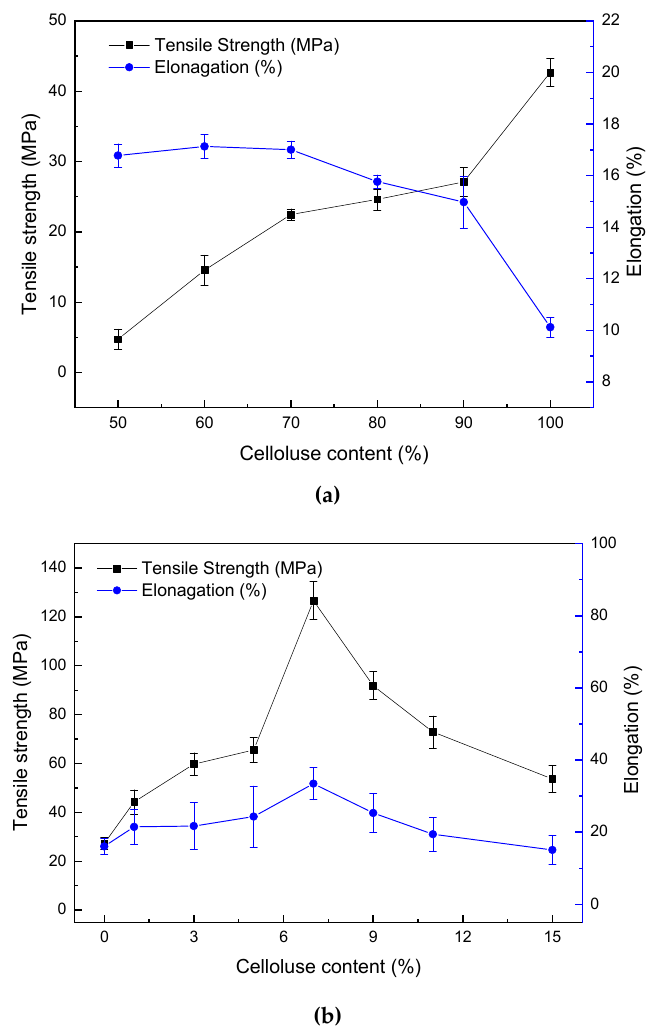
Figure 7. The mechanical properties for starch/cellulose blend materials with different cellulose content by ( a ) a casting method and( b ) a compression molding method. Error bars represent standard deviations.